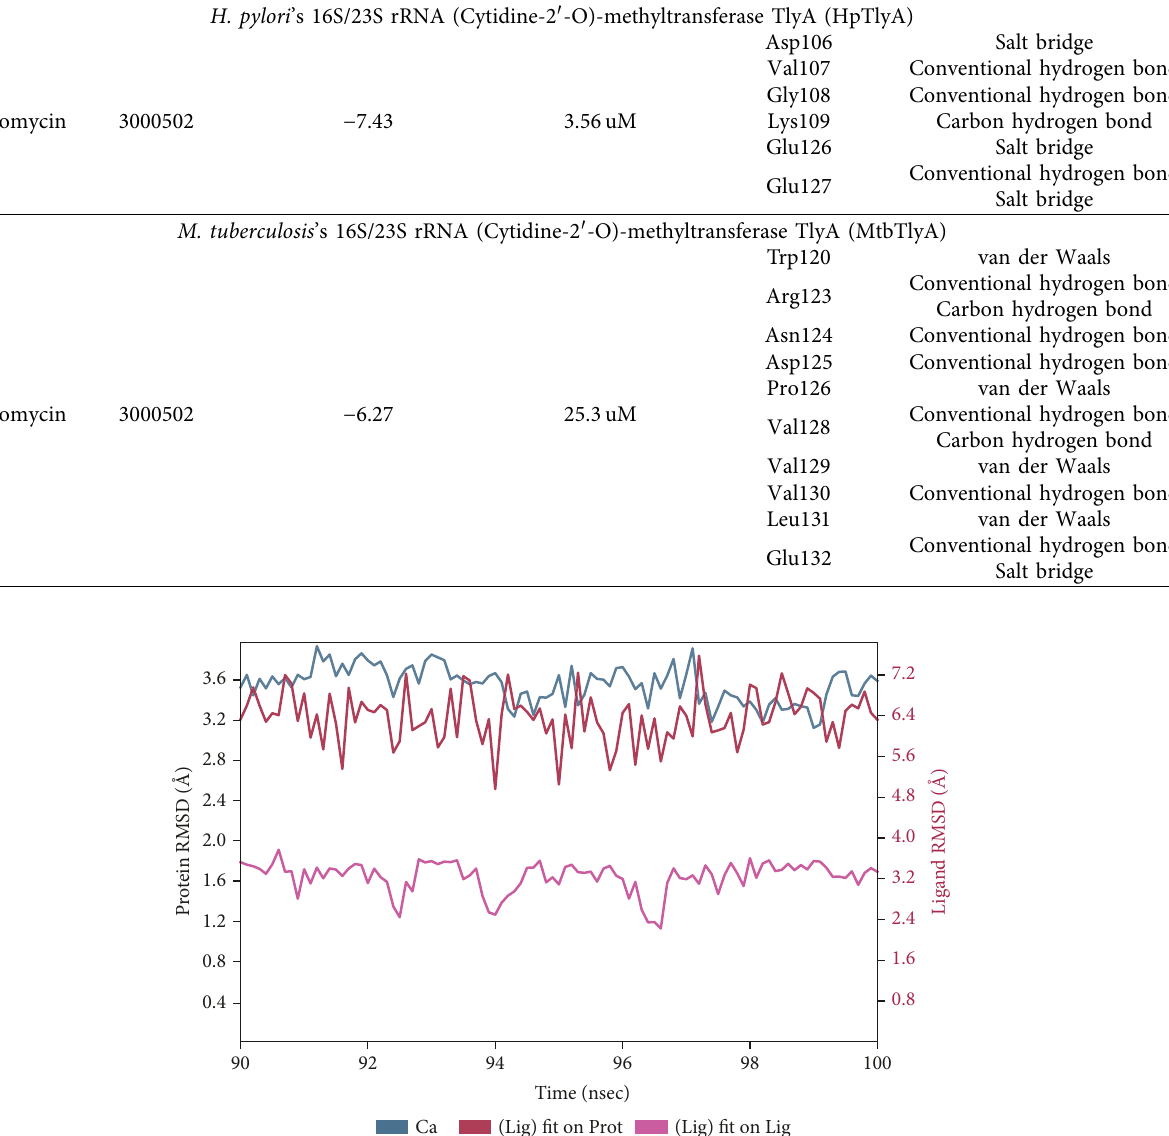
Table 2: Binding affinity and inhibitory constant prediction of capreomycin against HpTlyA and MtbTlyA. Compounds